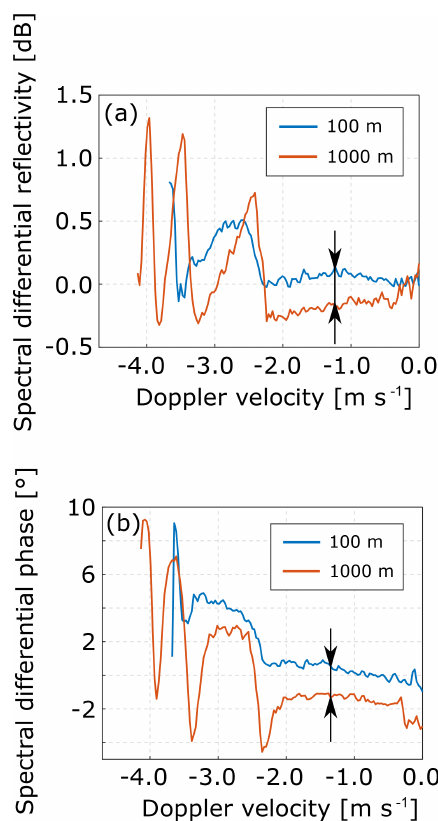
Figure 11. Doppler spectra of differential reflectivity (a) and dif- ferential phase (b) taken at 0.1 (blue lines) and 1km (red lines) for the case shown in Fig. 10. The differences between the observa- tions in the area of relatively slow-moving particles, indicated by the arrows, are associated with the propagation effects, namely dif- ferential attenuation in (a) and propagation differential phase in (b) .